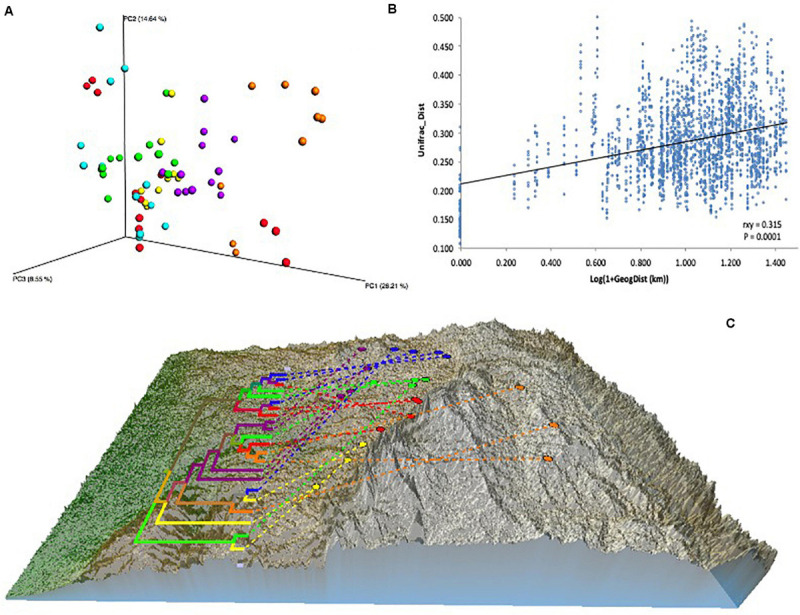
Effect of vineyard location on soil microbiome differentiation. (A) PCoA based on Beta diversity of soil bacterial communities calculated using weighted UniFrac distances. Values were calculated based on rarefied data to 37,176 sequences per sample. (B) Relationship between phylogenetic Beta diversity and geographic distance. Unifrac_dist indicates weighted UniFrac distances. Geographic distances were calculated from latitude/longitude coordinates using GenAlex v6.5 geographic distance function implemented as Log(1 + distances in Km). The relationship was tested using Mantel’s correlation coefficient (rxy) with its probability estimate for significance (P) based on 9,999 random permutations and implemented using GenAlex v6.5. (C) Neighbor joining ultrametric tree calculated from Beta diversity weighted UniFrac distance matrix between 22 vineyards located in six sub-regions: Northern Grounds (blue); Southern Grounds (yellow); Central Grounds (green); Eastern Edge (red); Western Ridge (purple); Eden Valley (orange). Tree was overlayed with the Barossa Region elevation map using GenGIS. Beta diversity was established using 16S sequencing reads from 3 soil samples per vineyard.